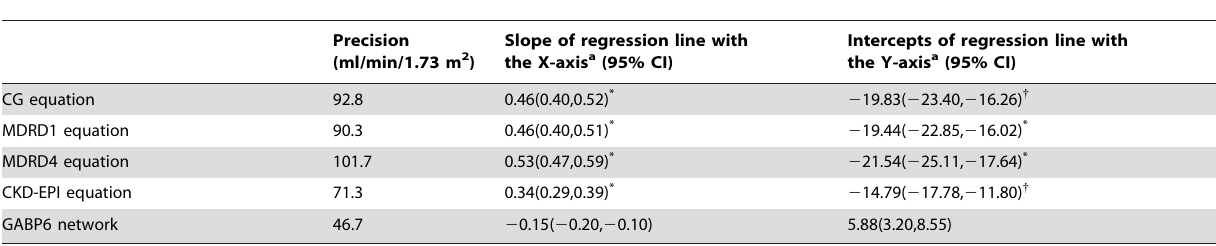
Table 2. Overall performance of agreement between eGFR and sGFR in the external validation data set.